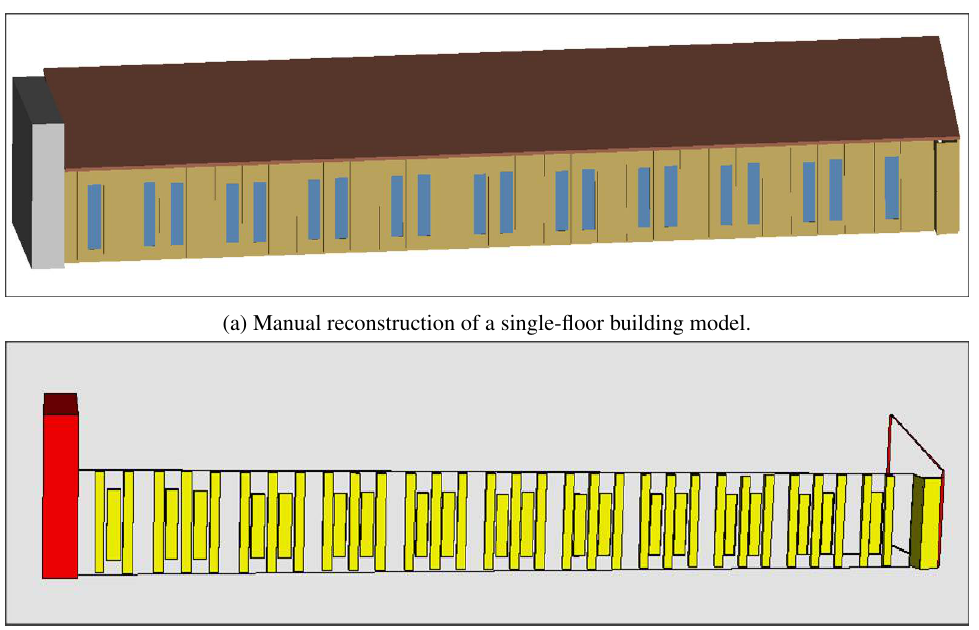
(b) Automatic reconstruction of a single-floor building model with Rule Set 1 . Only determined model